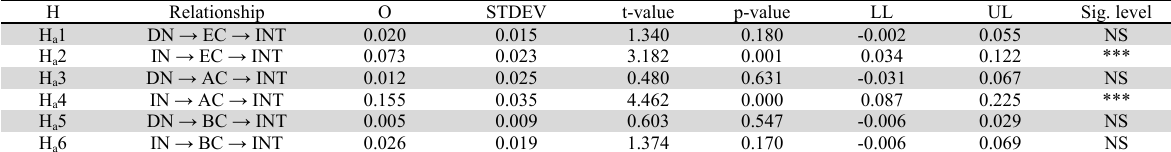
PLS Bootstrapping for Mediation of Environmental Concerns between the Independent Variables and Intention to Practice Solid Waste